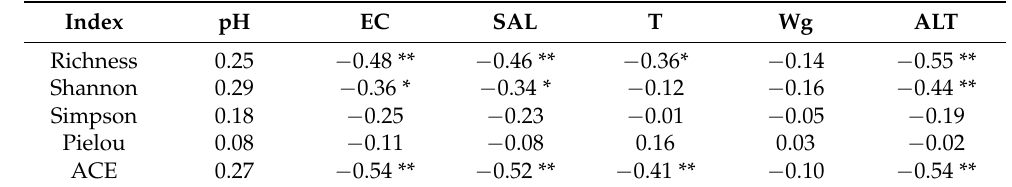
Table 2. Pearson’s correlation coefficients ( R ) between the alpha diversity index and environmen- tal factors. Index pH EC SAL T Wg ALT Richness